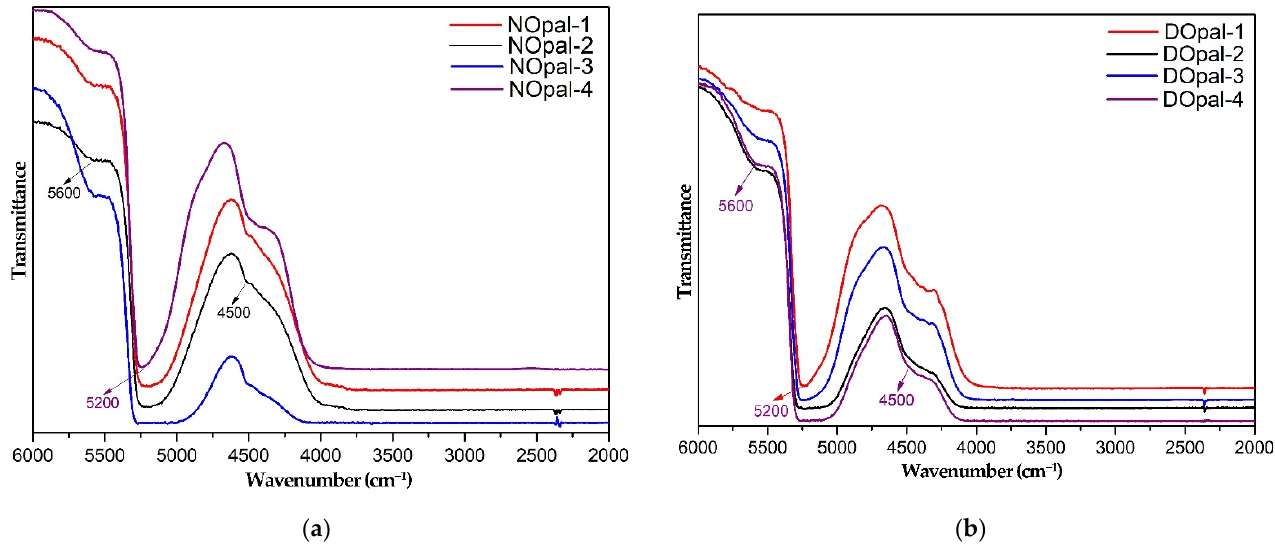
Figure 6. Mid-infrared spectra of samples (transmission method): ( a ) natural opals; ( b ) dyed